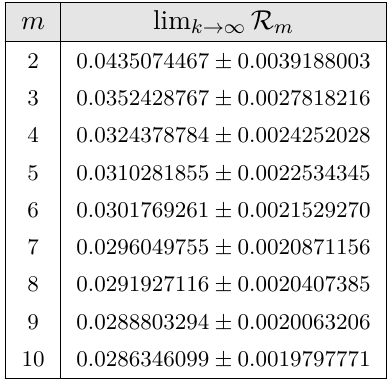
Table 9. The k → ∞ values of the Rényi entropies associated with the state | 5 2 # T 2 , 2 i .